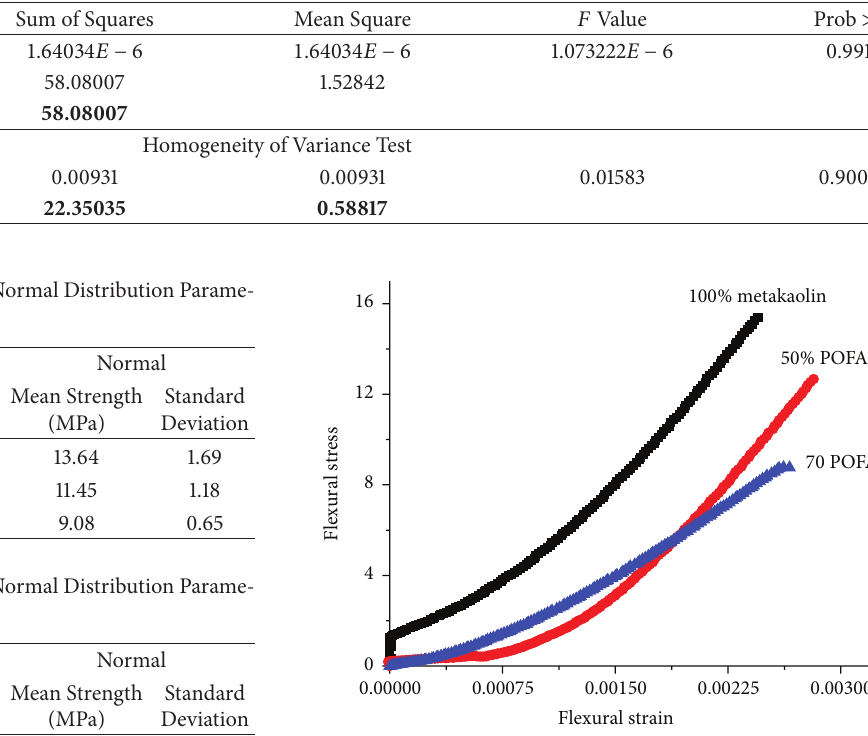
Table 3: One Way ANOVA of 100% metakaolin geopolymer Weibull regression.